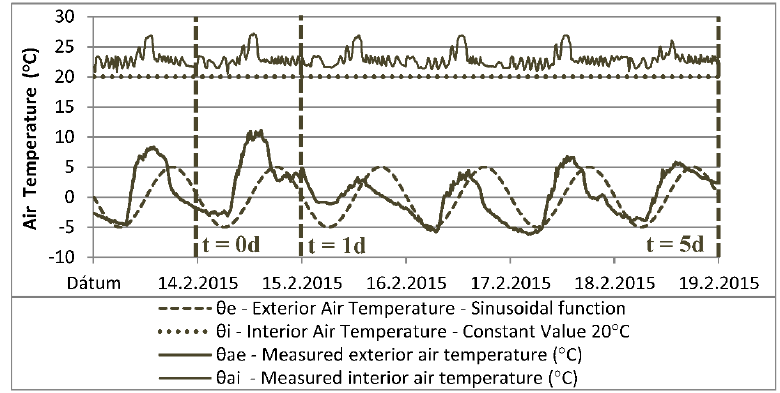
Figure 6. Measured, sinusoidal and constant ambient air temperature over the selected time period as the boundary condition used to determine the initial temperature conditions, as according to Section 2.4.